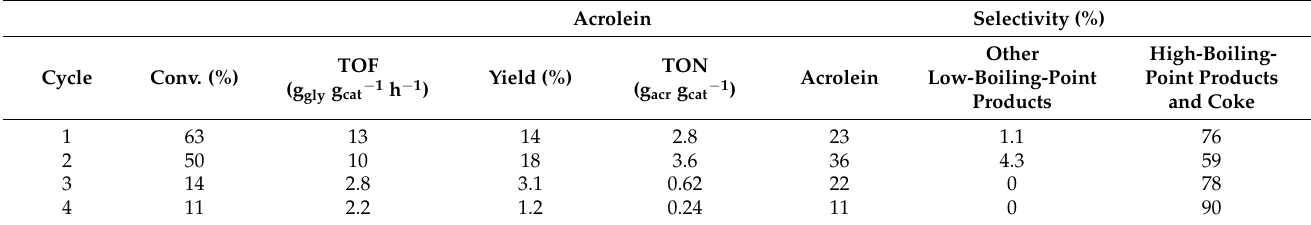
Table 5. Recycling data of ZSM-5_280 in liquid-phase dehydration of glycerol *. Acrolein Selectivity